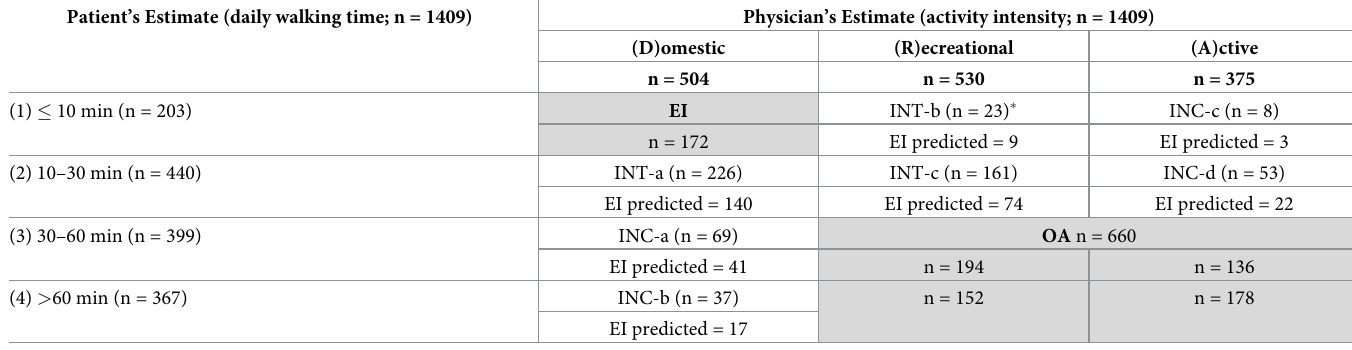
Table 1. Categorization of physical activity levels in COPD patients according to combined patient- and physician-derived estimates. Patient’s Estimate (daily walking time; n =